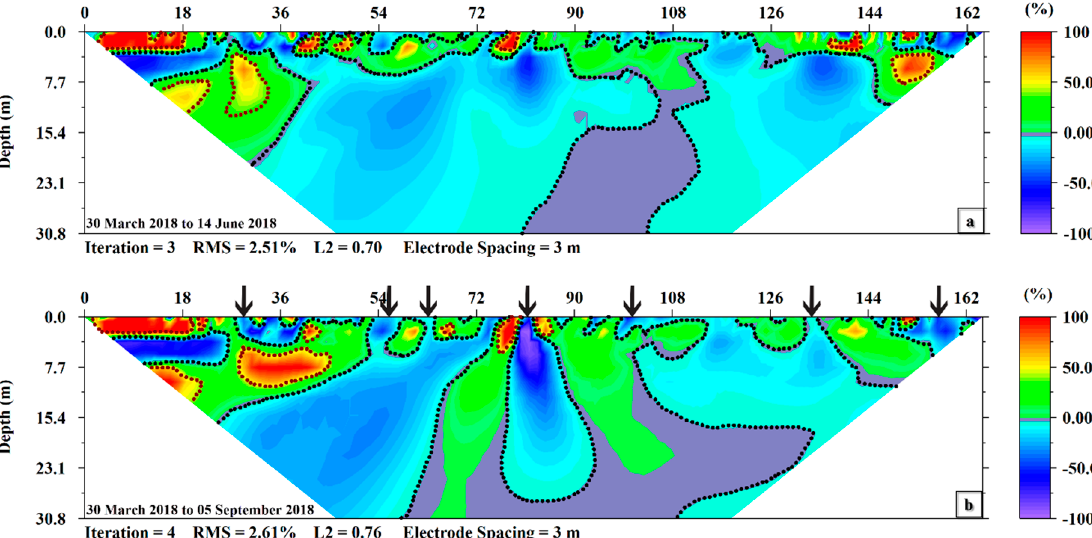
Figure 11. Time-lapse inversion of line two with root mean squared (RMS) error: ( a ) 30 March 2018 to